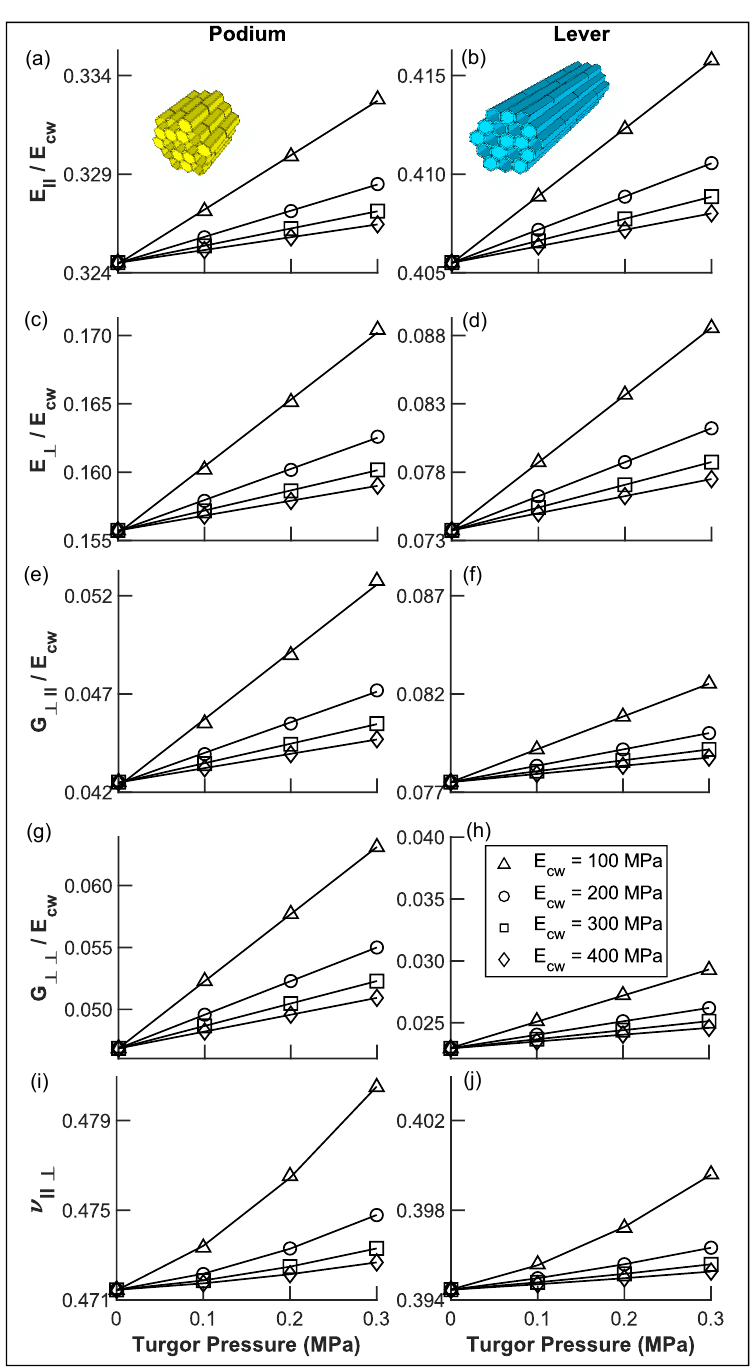
Figure A1. Homogenized transverse isotropic tissue properties of the podium ( left ) and the lever ( right ) are calculated for different turgor pressures and cell wall elastic moduli E cw ( △ = 100MPa, ◯ = 200MPa, ◻ = 300MPa, and ◇ = 400MPa). The five transverse-isotropic material parameters consist of the longitudinal elastic moduli E ∥ ( a , b ), the transverse elastic moduli E (cid:150) ( c , d ), the lon- gitudinal shear moduli G (cid:150)∥ ( e , f ), the transverse shear moduli G (cid:150)(cid:150) ( g , h ), and the Poisson’s ratio ν ∥(cid:150) ( i , j